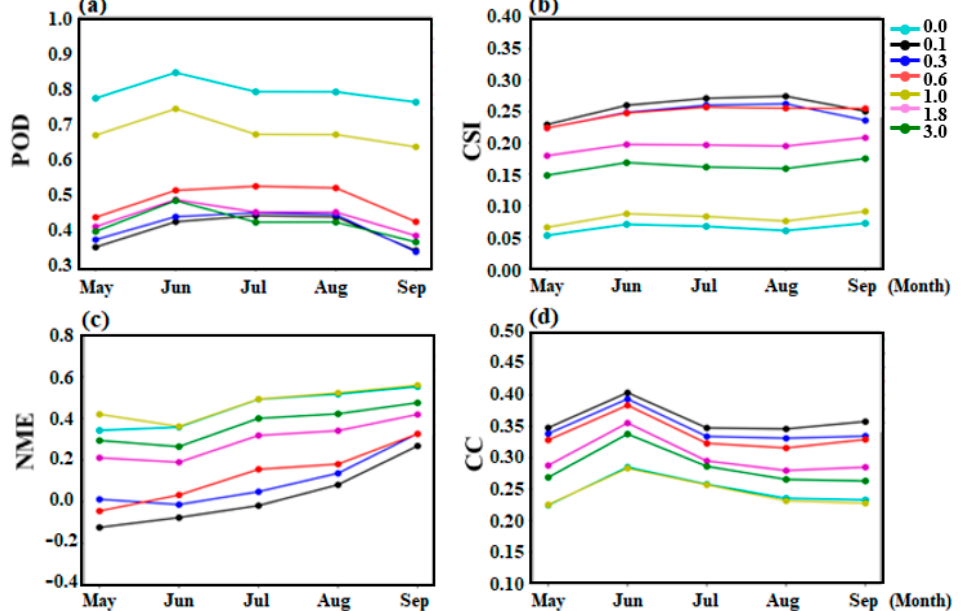
Figure 11. Evaluation statistics of the GOES-16 QPE hourly rainfall under different rain/no-rain thresholds over CONUS-east from May to September 2018: ( a ) POD ; ( b ) CSI ; ( c ) NME ; and ( d ) CC . From May to September, the best scores for the four metrics were 0.85 ( POD ), 0.1 ( CSI ), 0.35 ( NME ), and 0.25 ( CC ) when the threshold was 0 mm/h. When the threshold was increased from 0 to 3.0 mm/h, the detection skills (in terms of POD ) degraded, while other